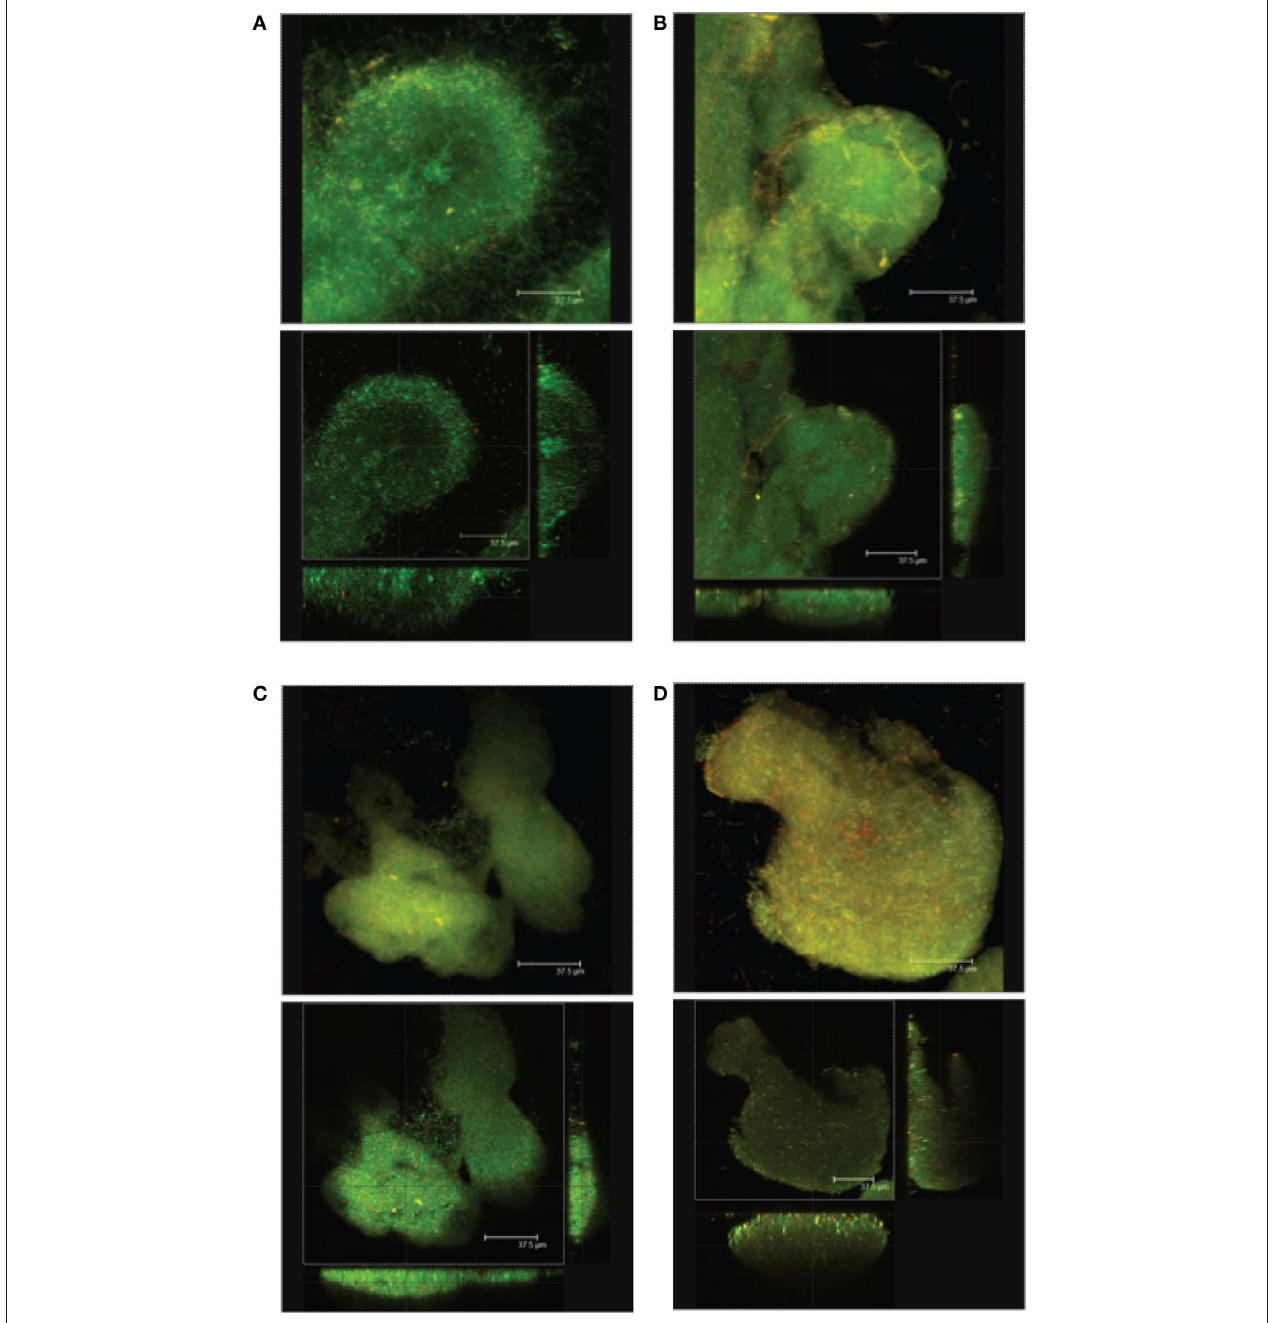
FIgure 7 | Images from confocal laser scanning microscopy analyses of P. aeruginosa cells that illustrate the changes in biofilm structure resulting from truncation in the LPS core in mutant strains as comparing to the wildtype bacteria. Average projections (top panels) and midpoint